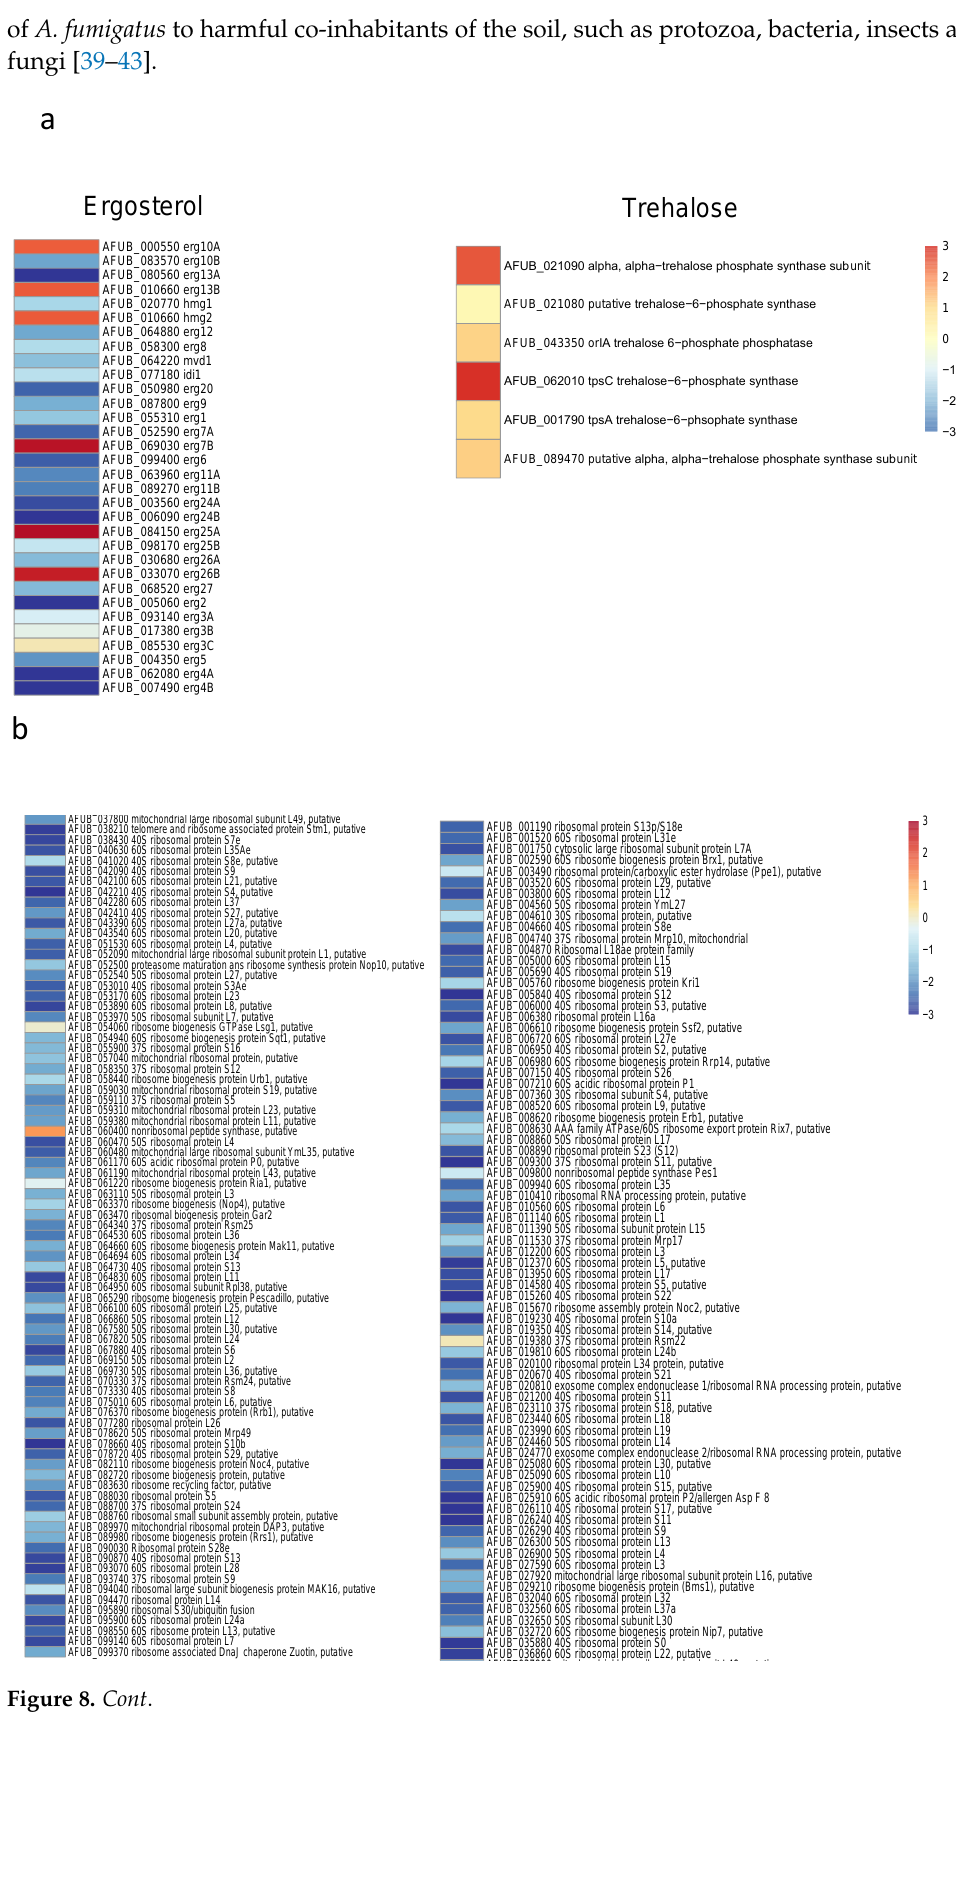
Figure 8. Heat maps showing significative examples of differentially regulated A. fumigatus genes during germination in GAP and MM media. Level of expression of genes for a ratio GAP/MM : a, down regulation of ergosterol synthesis and upregulation of trehalose synthesis suggesting the entrance in quiescence of conidia germinating in GAP medium; b, ribosome and protein synthesis pathways down regulated in absence of growth in GAP medium;;c, Down regulation of cell wall synthases and up regulation of autolytic cell wall glycosyl hydrolases indicating that the germ tubes are starved in GAP medium; d, high expression of genes coding for plant material degrading glycosylhydrolases indicating the starvation status of GAP cells and the attemps to its quest for food.